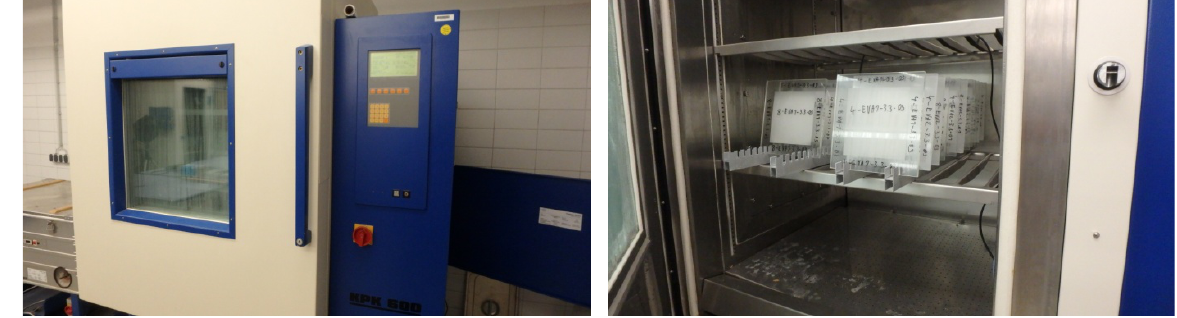
Fig. 21 Environmental chamber used Fig. 22 Samples in the environmental chamber